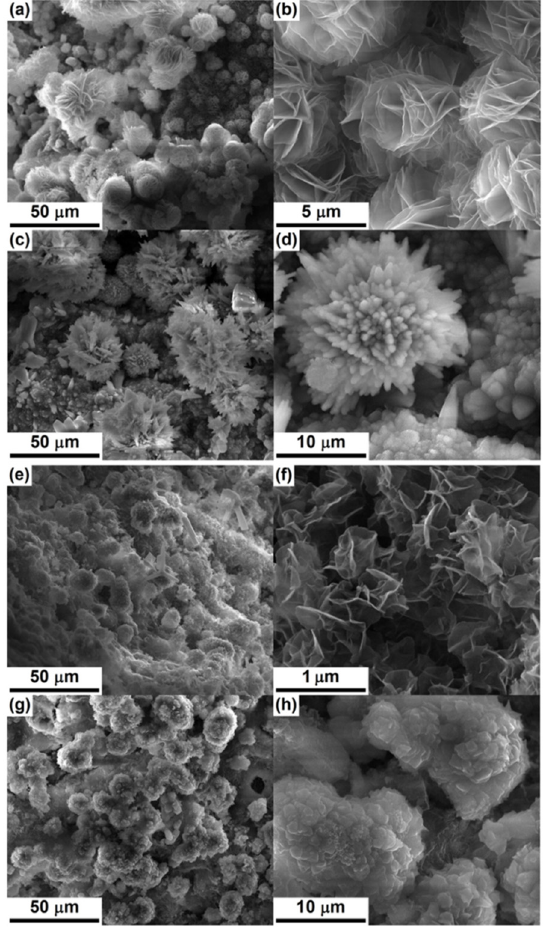
Figure 5. SEM images of hardened (for 28 days) unitary and cement pasts after immersion in SBF for 14 days: ( a , b ) C1, ( c , d ) C2, ( e , f ) C1-BNC, and ( g , h ) C2-BNC. Reproduced with permission from [109]. Copyright 2017 Elsevier.